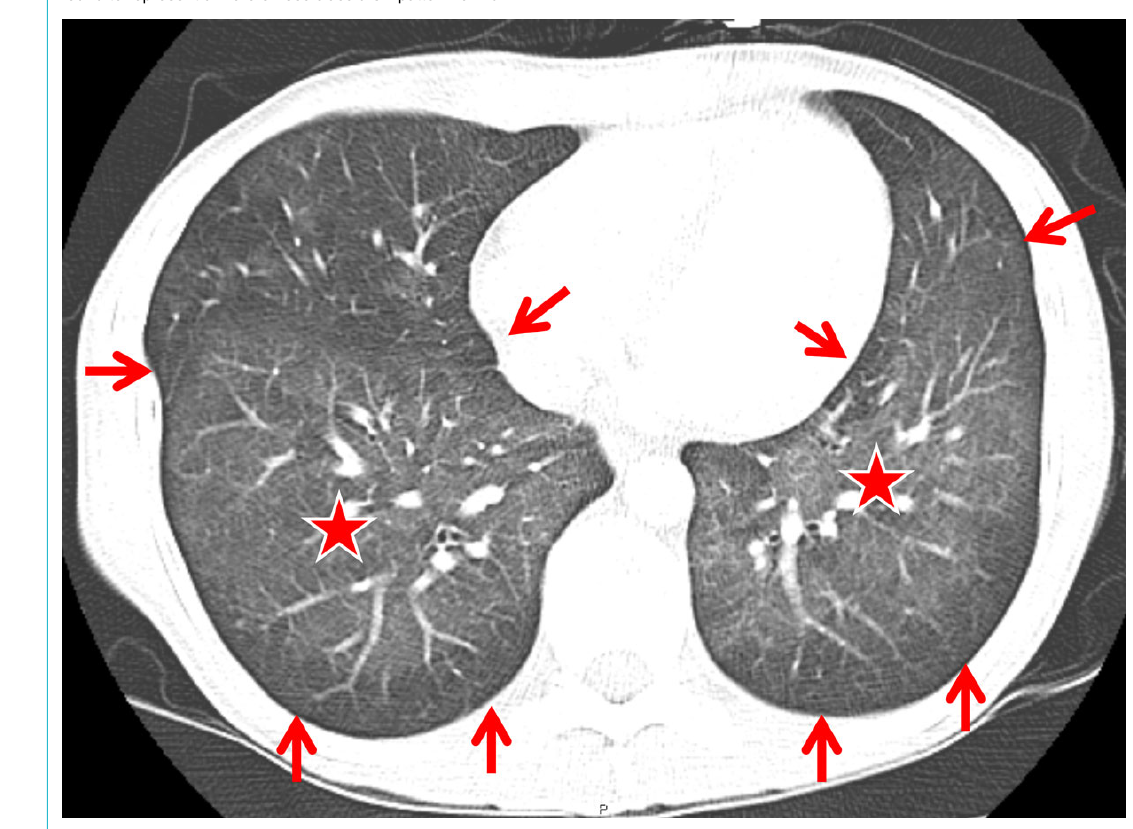
Figure 2: Computed tomography (CT) findings in a human immunodeficiency virus-positive patient suffering from Pneumocystis jirovecii pneu- monia (PJP) (axial CT section at the level of the lung bases): diffuse ground glass opacity (asterisk) and subpleural sparing (arrows) was found to represent a more or less classic CT-pattern for